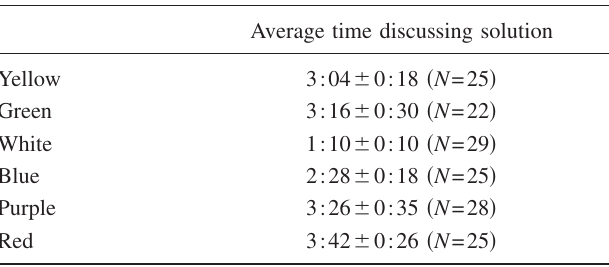
TABLE V. Average time spent discussing the CQ solution (cid:1) minutes:seconds, N =number of questions (cid:2) Average time discussing solution